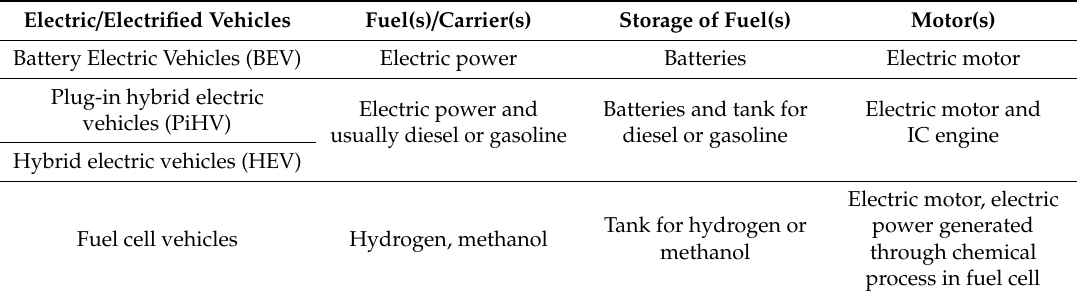
Table 2. Electric and electrified